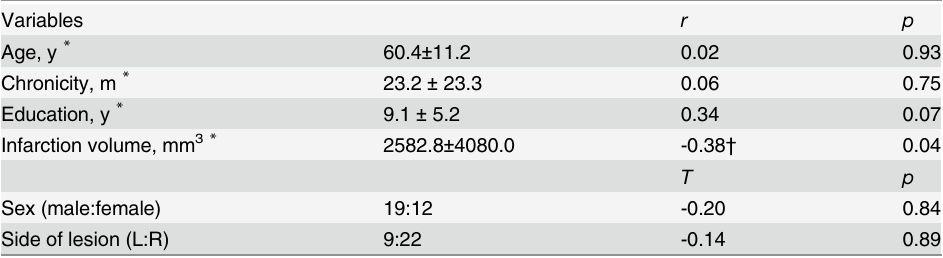
Table 2. Relationships between demographic data, disease characteristics, and UE-FM assessment (n =